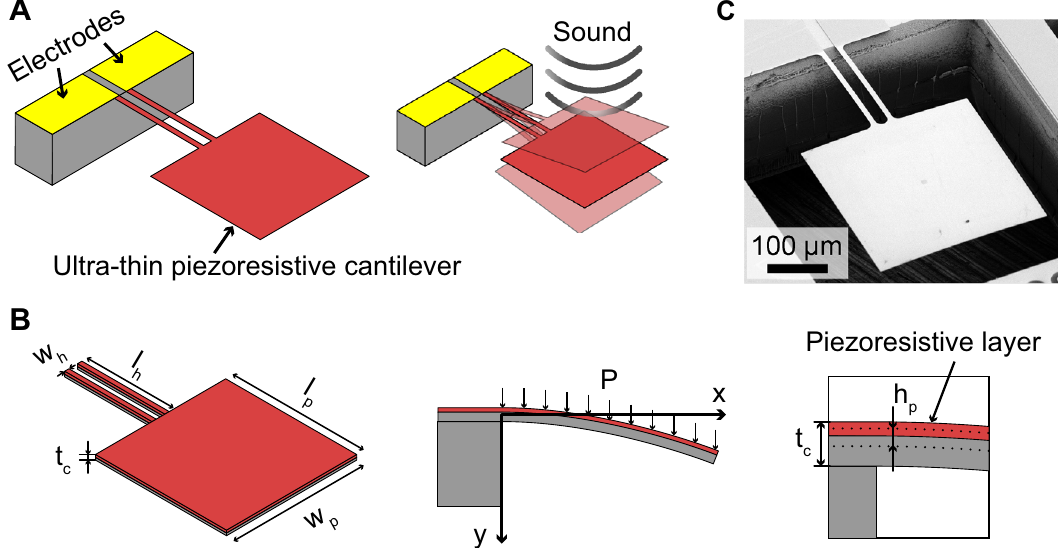
Figure 1. ( A ) Conceptual illustration of the proposed microphone using a piezoresistive cantilever. ( B ) Definition of the design parameters of the cantilever. ( C ) SEM image of the fabricated